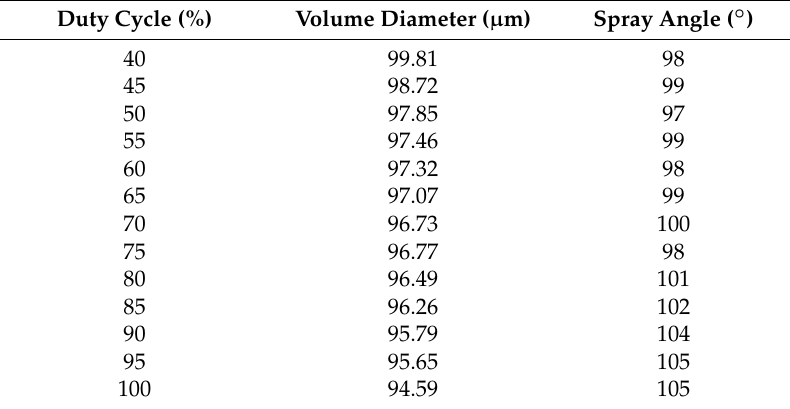
Table 1. Diameter of droplet volume and spray angle at different duty ratios of PWM square waves.